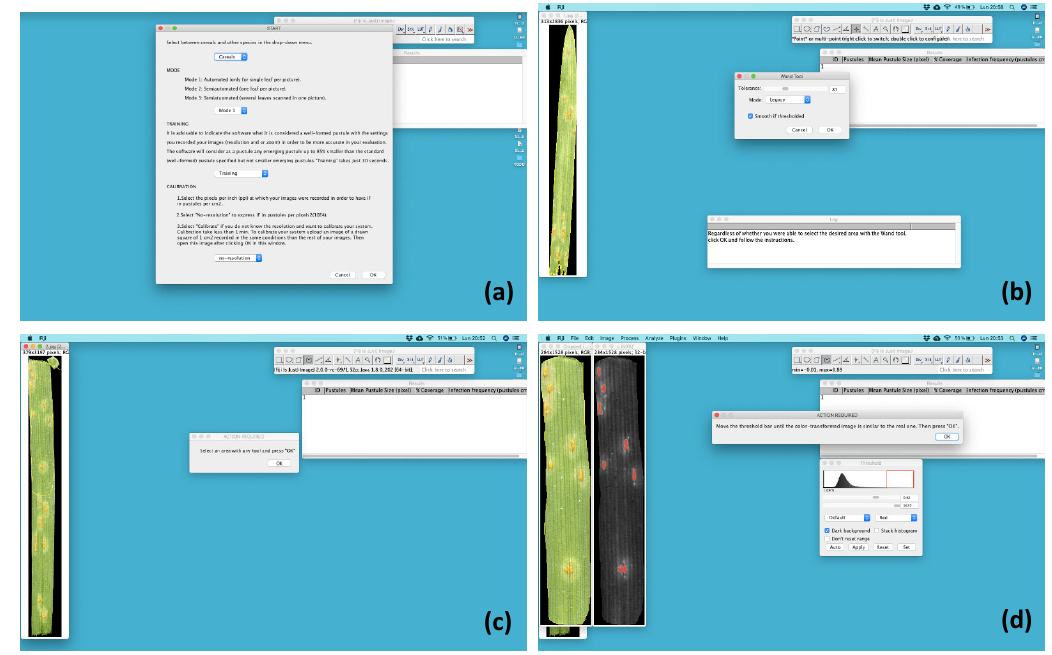
Figure 2. Screenshot of the Fiji application running RUST. ( a ). Screenshot for selecting crop, mode of evaluation, training / calibration option, and resolution. ( b ) and ( c ) Screenshot of the area selection step through the ( b ) automated wand tool or ( c ) manual selection. ( d ). Screenshot of the color transformation step that identifies rust pustules.